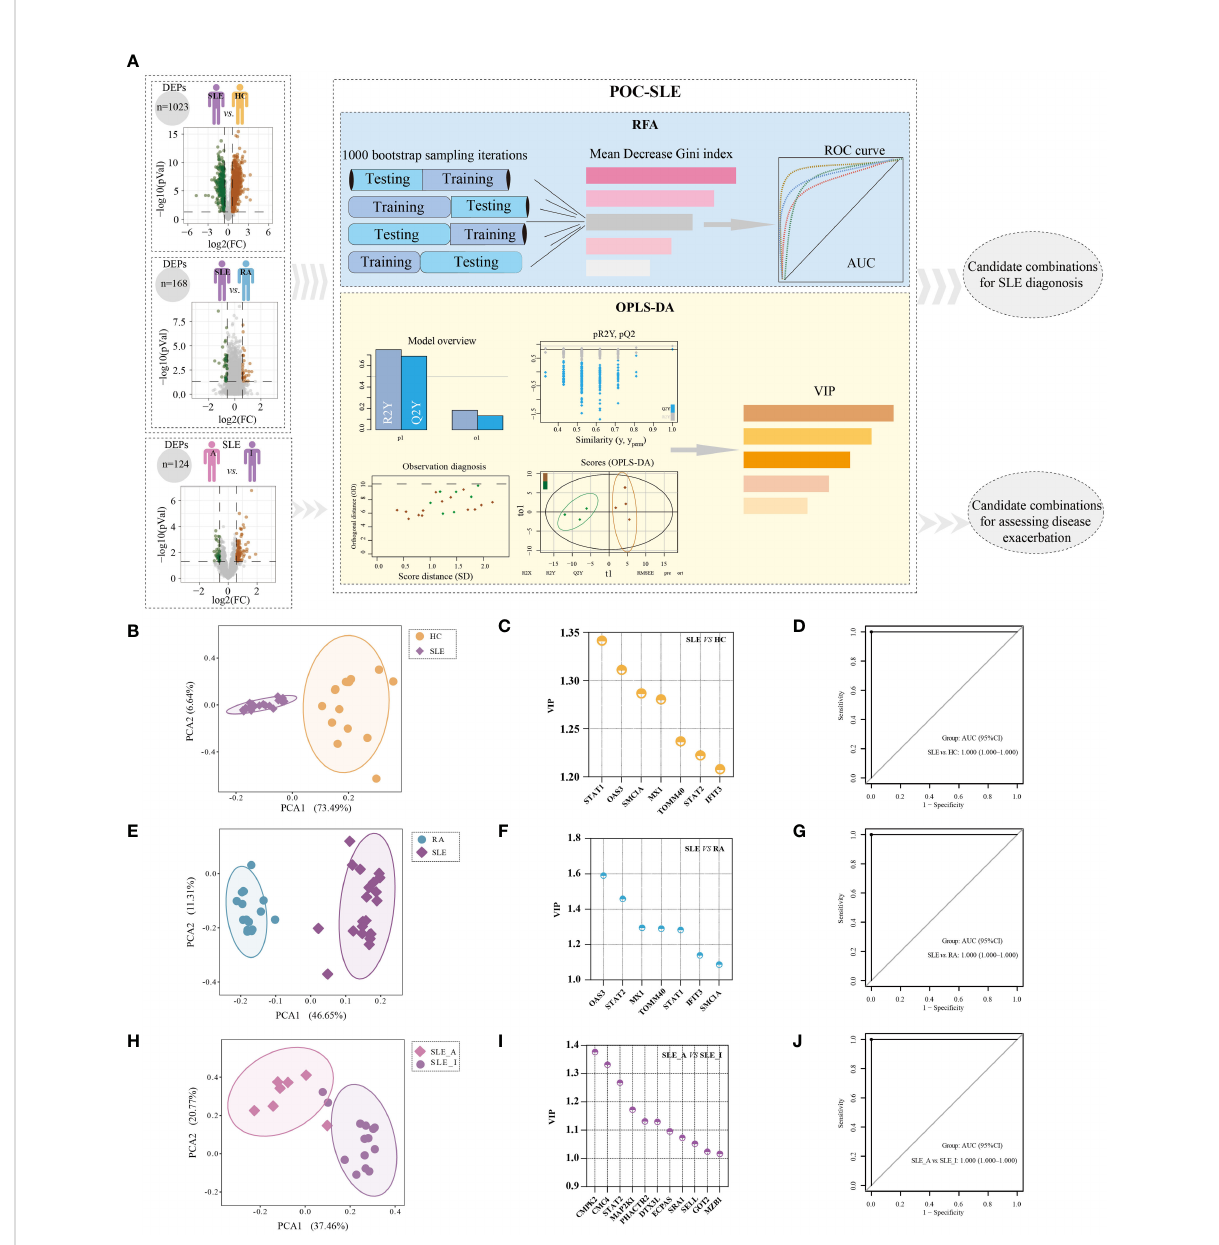
FIGURE 4 Identi fi cation of potential biomarker combinations for the disease diagnosis and assessing disease exacerbation of SLE patients. (A) The work fl ow of POC-SLE, including 1000 bootstrap sampling iterations RFA and OPLS-DA. The PCA plot for distinguishing SLE and HC (B) , SLE and RA (E) , and SLE_A and SLE_I (H) . The VIP value of potential biomarker combinations for discriminating SLE and HC (C) , SLE and RA (F) , SLE_A and SLE_I (I) . ROC curve of the biomarker combination for disease diagnosis to differentiate SLE and HC (D) , SLE and RA (G) ; ROC curve of the biomarker combination for assessing disease exacerbation to distinguish SLE_A and SLE_I (J)